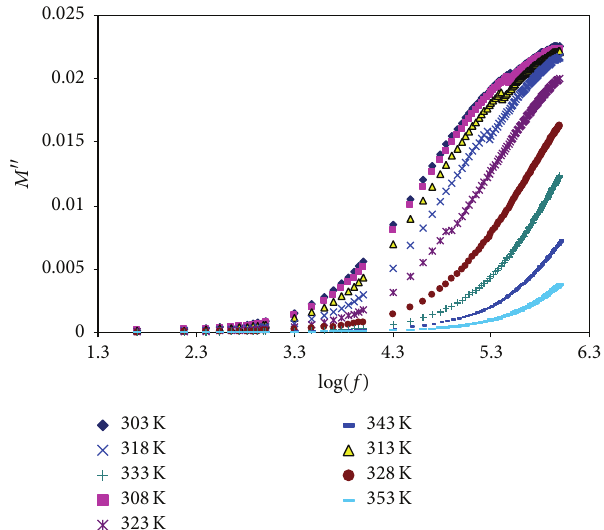
Figure 18: Frequency dependence of 𝑀 󸀠󸀠 at different temperature for CSNC2